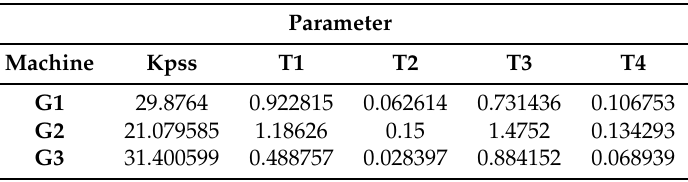
Table 2. Optimal parameters system